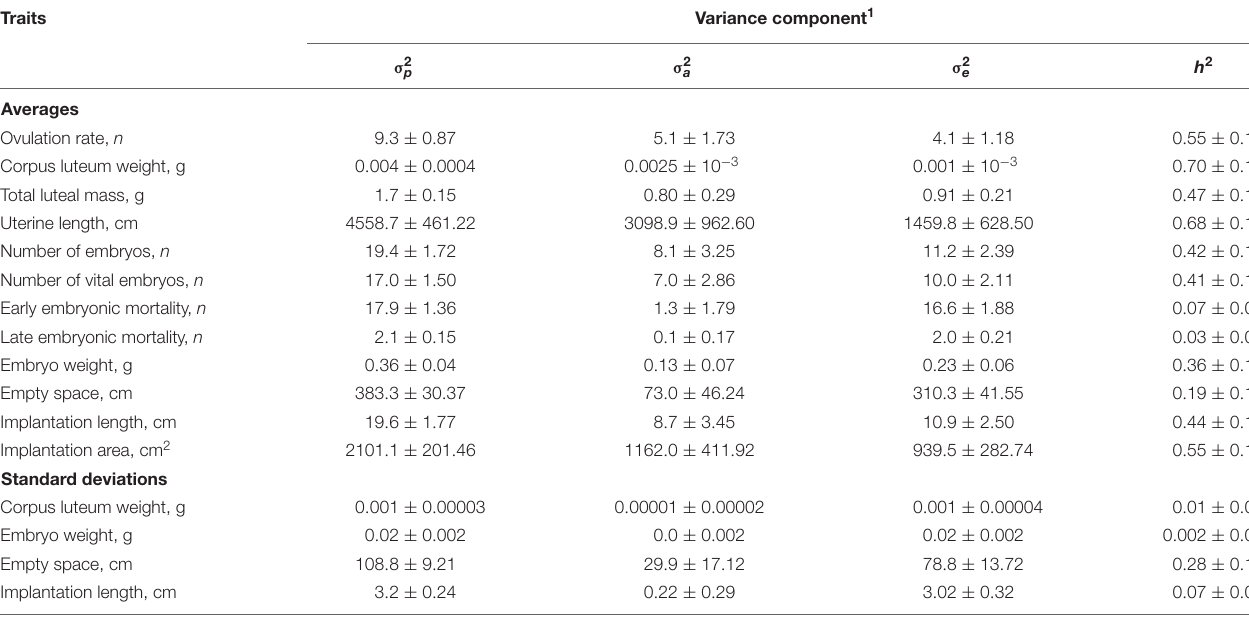
TABLE 3 | Estimated variance components and heritabilities ( ± the standard errors) of ovarian, uterine, and embryonic characteristics in gilts at 35 days of pregnancy ( n = 390).